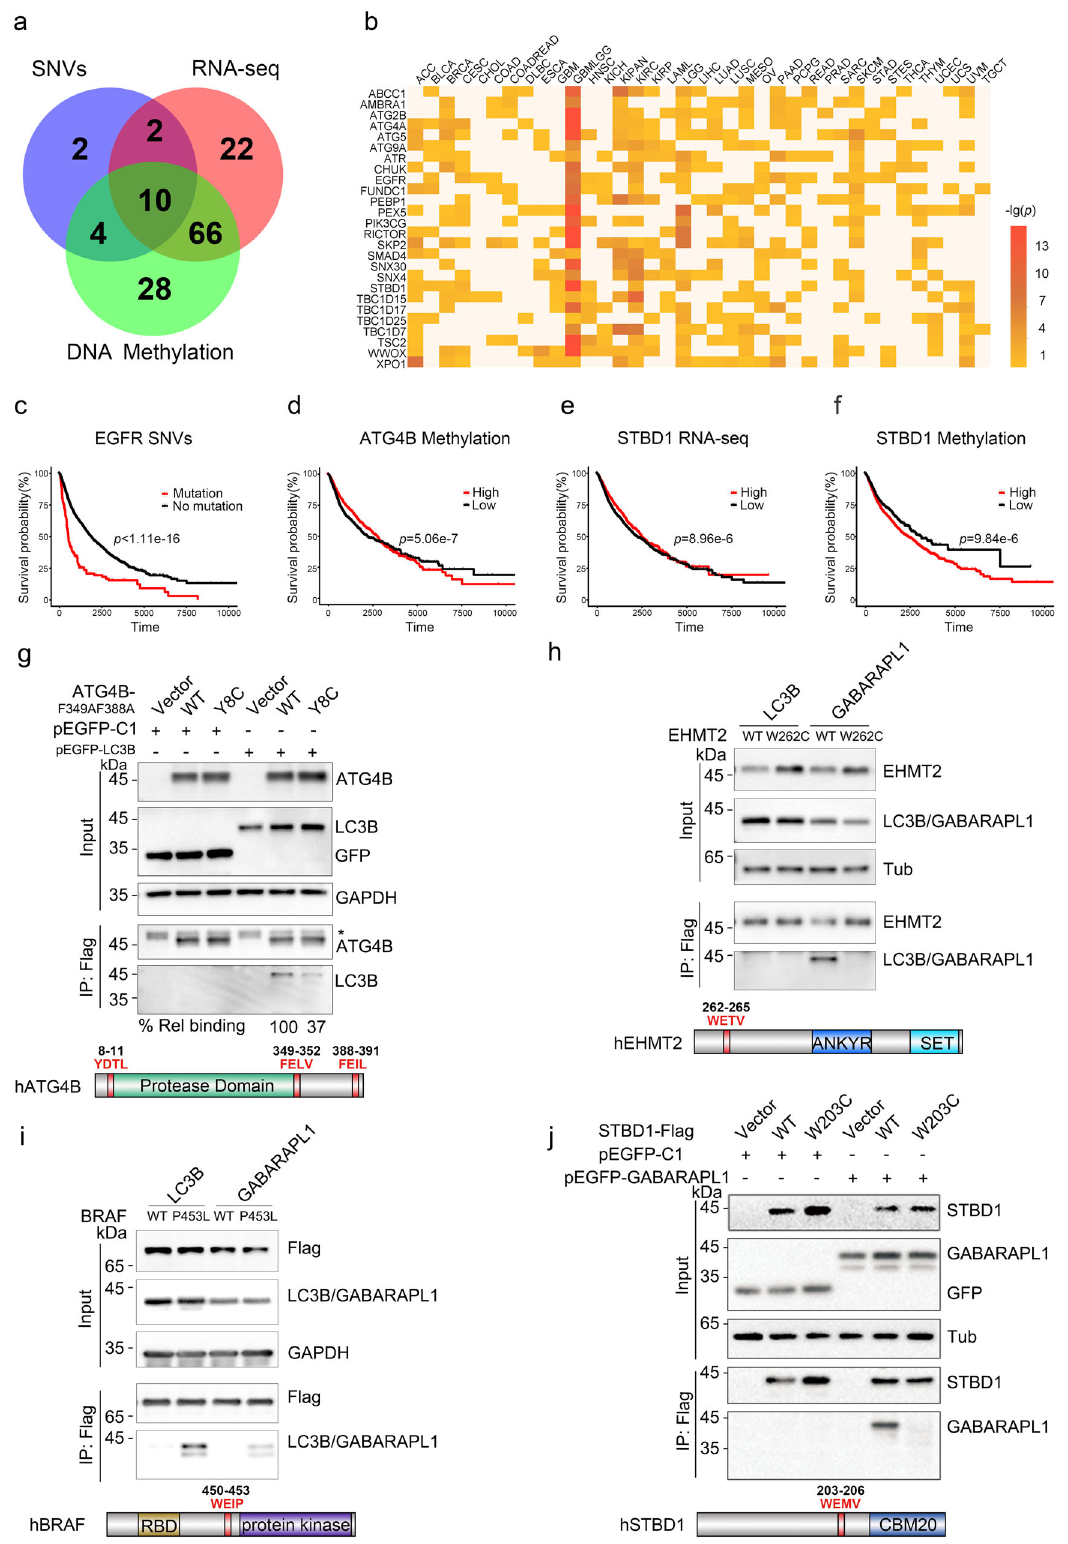
DNA methylation level of ATG4B is statistically correlated with a higher survival rate, supporting its oncogenic role in tumorigenesis (Fig. 3d). In particular, we observe STBD1, a protein involved in glycophagy, to be potentially associated with human cancer (Supplementary Data 4). At the pan-cancer level, it is found that a higher mRNA expression level or a lower